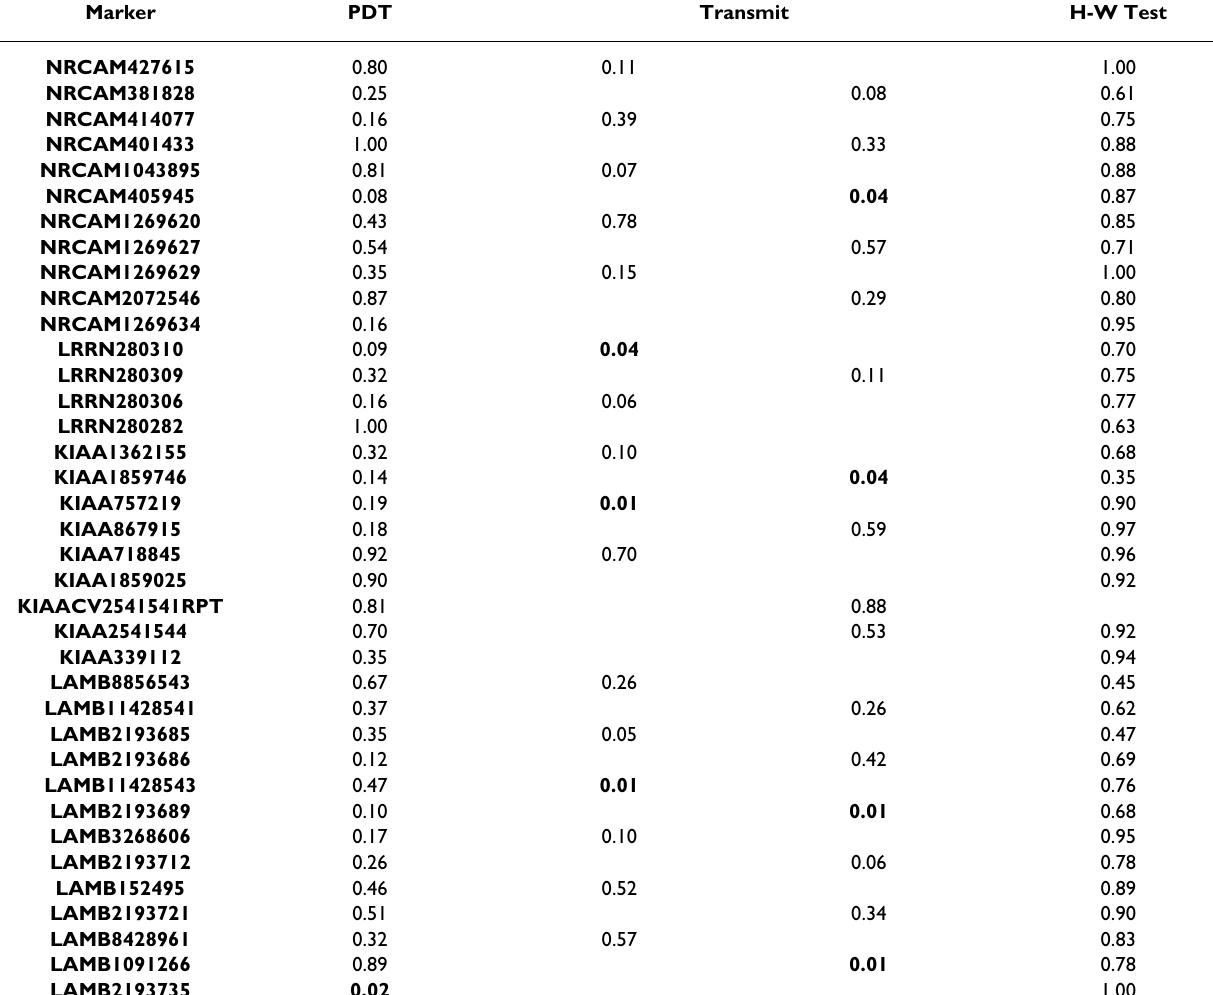
Table 3: Candidate gene association results (results given as nominal p -values) Marker